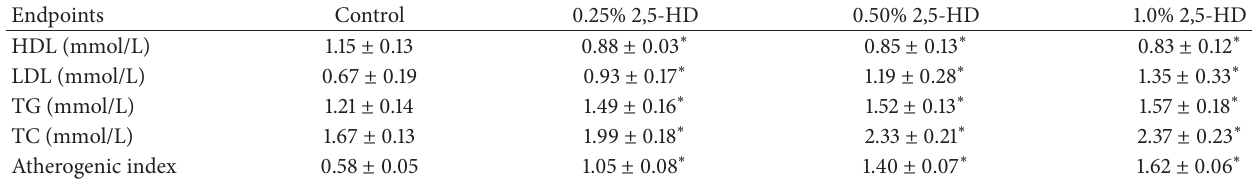
Table 3: Lipid profile in male rats exposed to 2,5-hexanedione for 21 days.